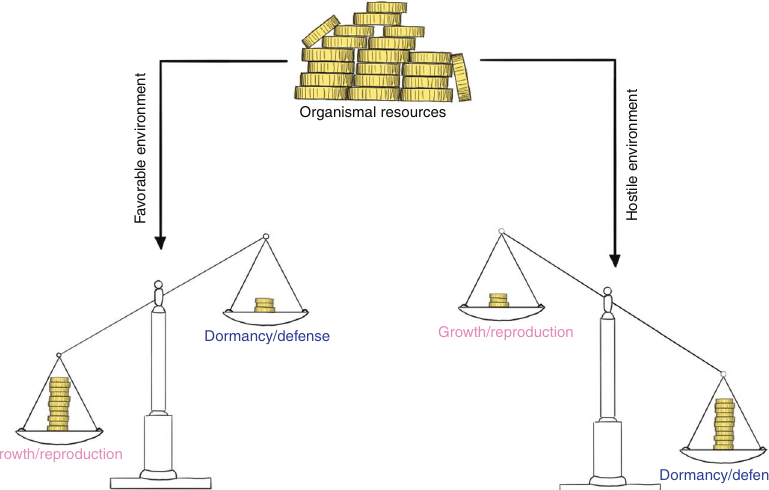
Fig. 3 Life history trade-offs. Finite organismal resources have to be allocated to competing (opposing) biological programs through trade- offs. The underlying investment strategy is largely driven by environmental factors (life history theory). Whereas favorable environments promote resource allocation into growth and reproduction, hostile environments foster investments into dormancy and defense (collectively referred to as maintenance programs). This strict separation is crucial to maximize reproductive success and a common theme among life on